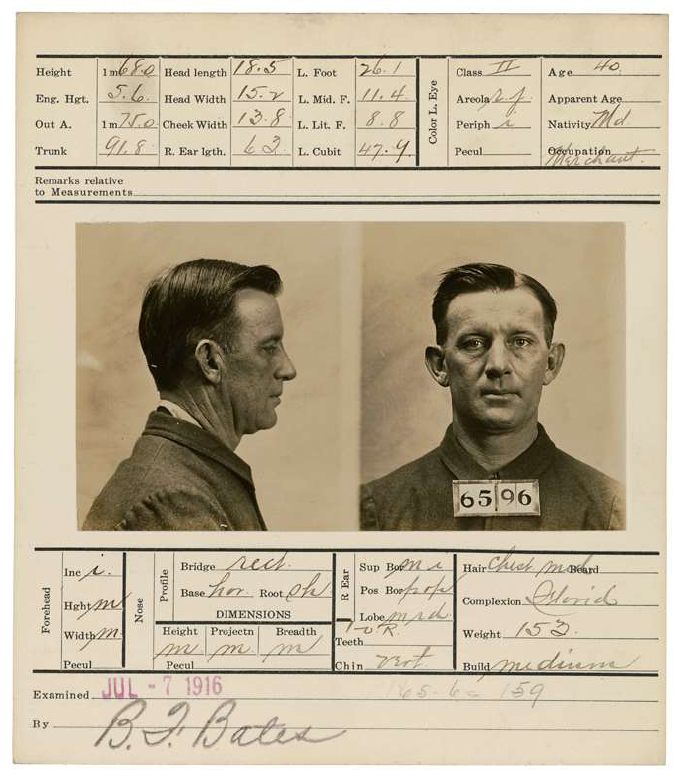
Bertillon Card for John